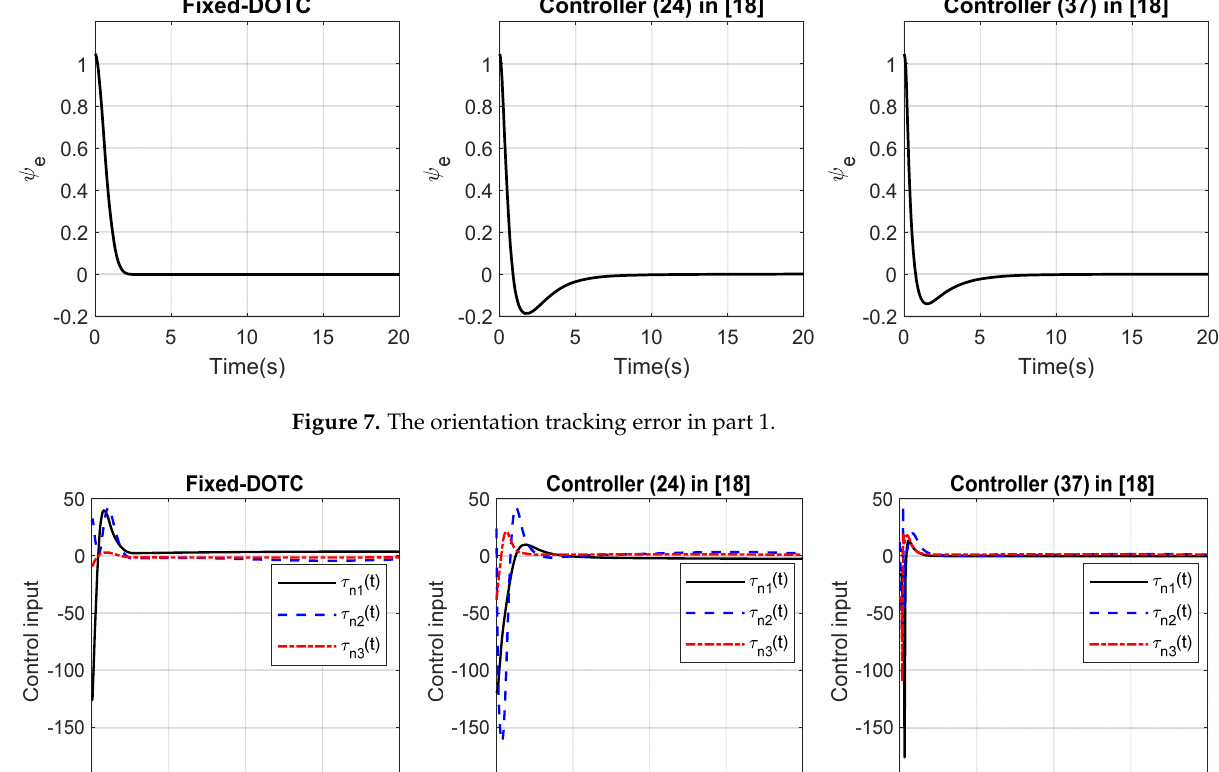
Figure 6. The position tracking errors in part 1.